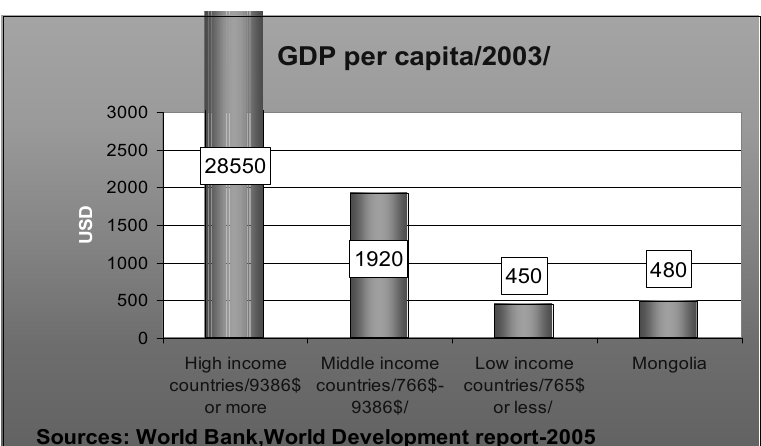
Fig. 3 – Real growth of GDP per capita GDP per